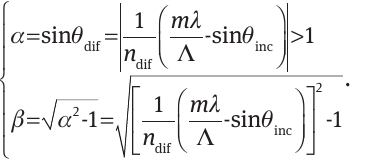
In Figure 1C, the case when diffraction results in non-